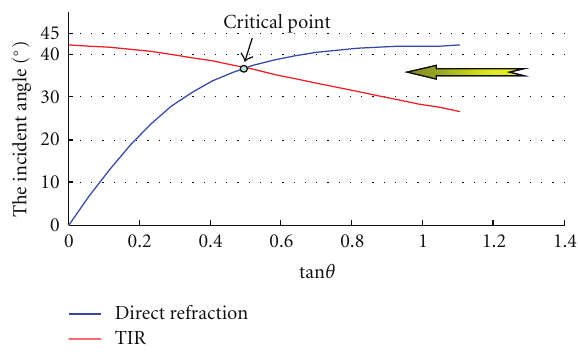
Figure 3: The change of incident angle i with convergent angle θ . The refractive index of Fresnel lens is adapted as n = 1 .